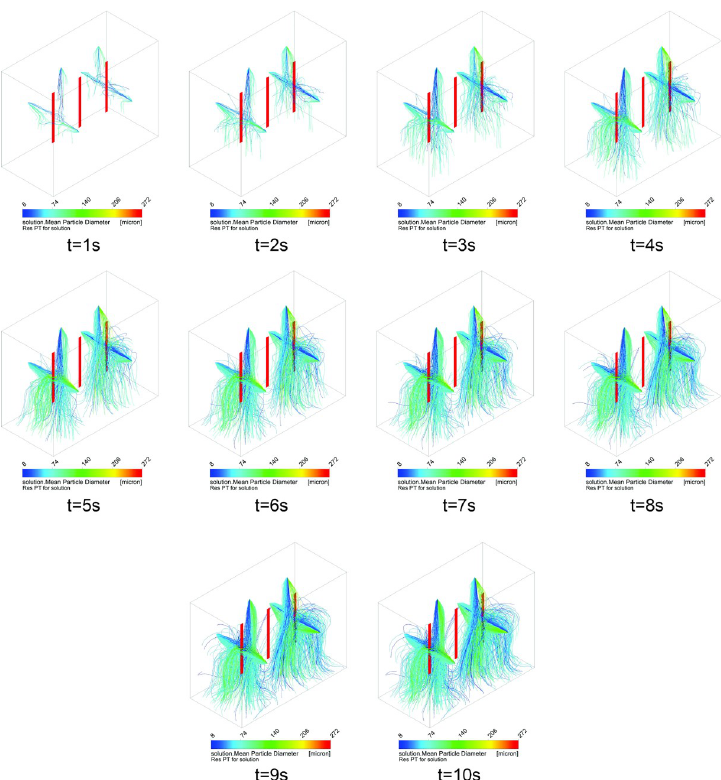
Fig 13. Dispersion of the droplets generated by the six nebulizer nozzles in the disinfection chamber during the exposure time of 10 s.